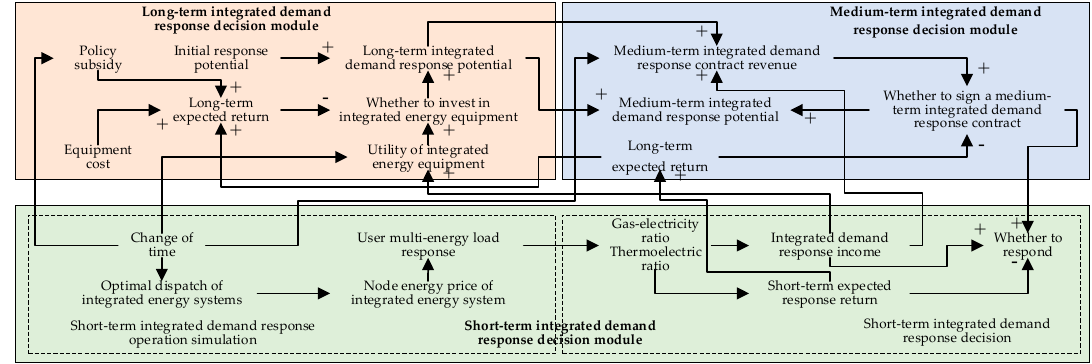
Figure 2. Causal loop diagram.